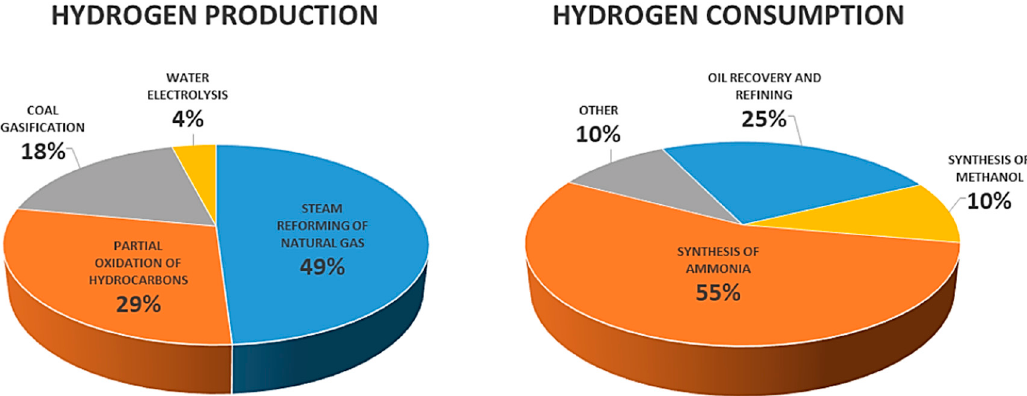
Figure 1. Global hydrogen production and consumption.